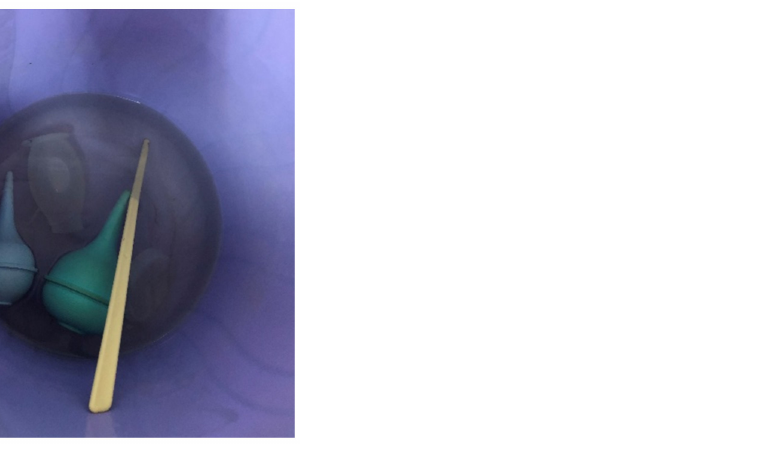
Figure 3. Combination of multi- and single- use equipment undergoing chemical disinfection in a maternity ward in Kenya. Image A. White,